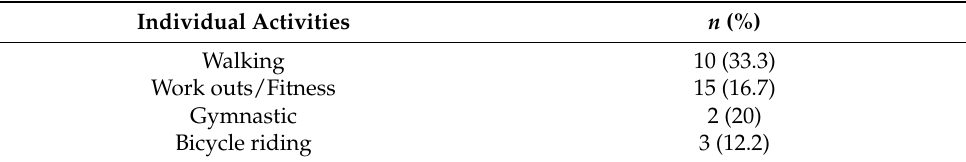
Table 7. Type of physical activities.